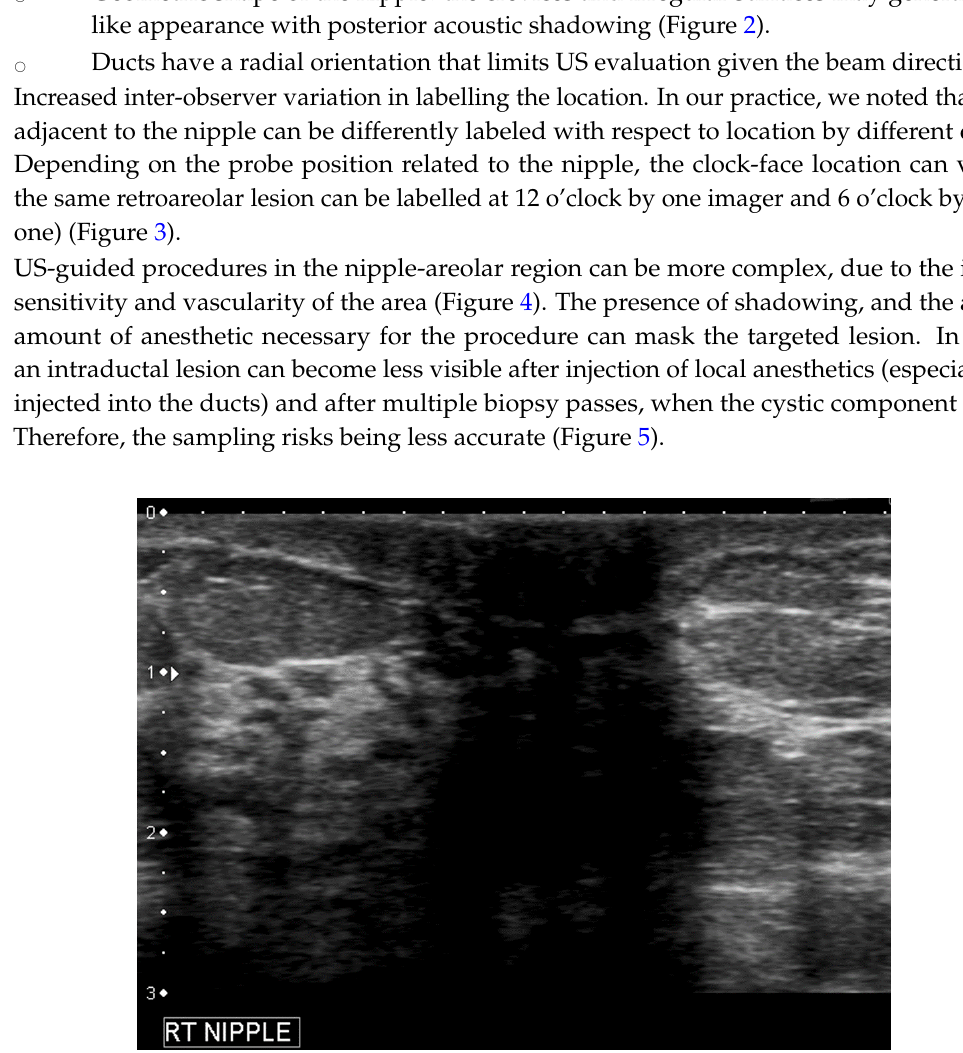
Figure 2. US image of the retroareolar area in a 64 year-old patient. Acoustic shadowing due to the nipple. Crevices and irregular surfaces can be responsible for a mass-like appearance.